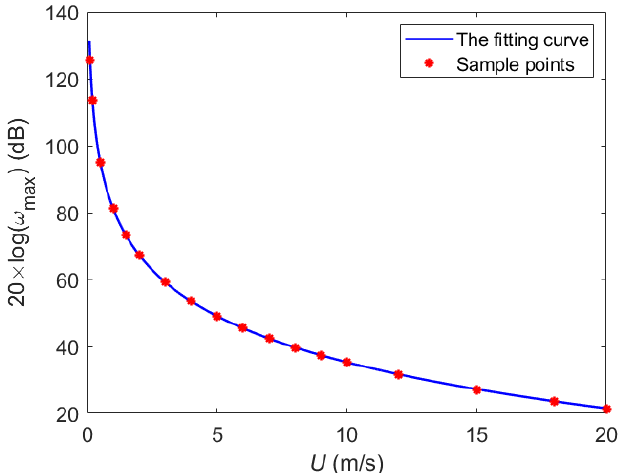
Figure 6. Sample points are fitted by Equation (21) perfectly; ω max is rescaled by log.